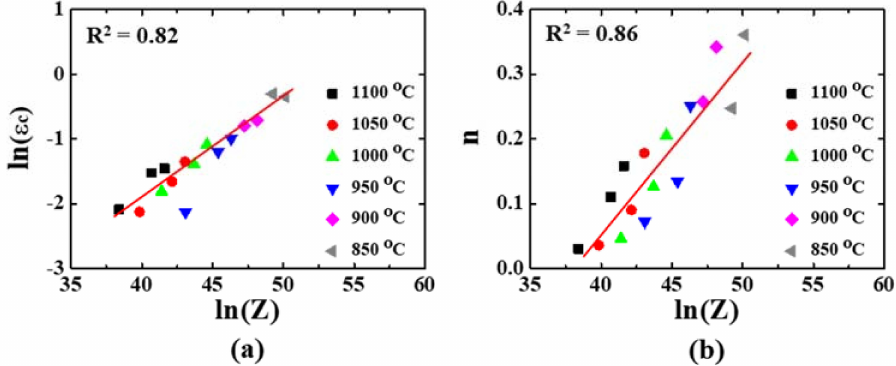
Figure 7. ( a ) Critical strain ε c and ( b ) work hardening coefficient n according to Zener–Holloman parameter.